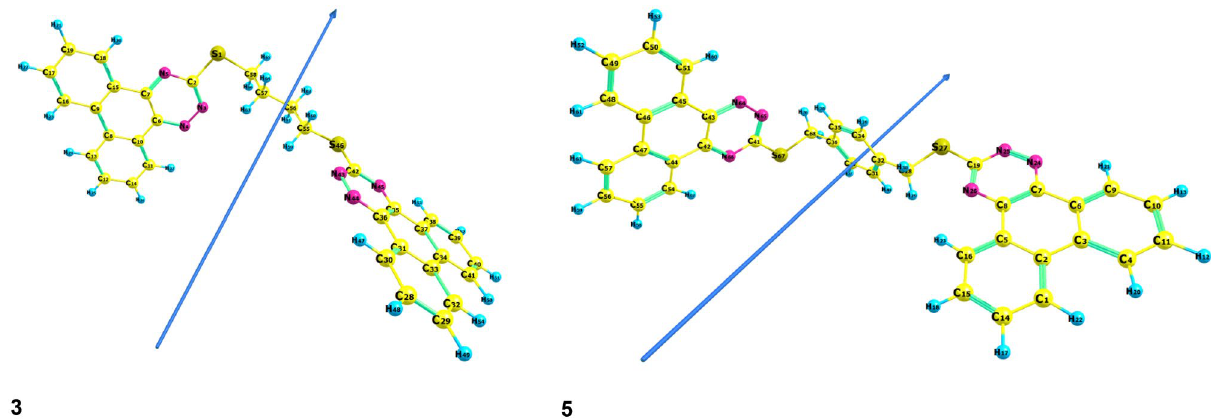
Figure 2. Optimized geometry, numbering system, and vector of dipole moment of 3 and 5 using B3LYP/